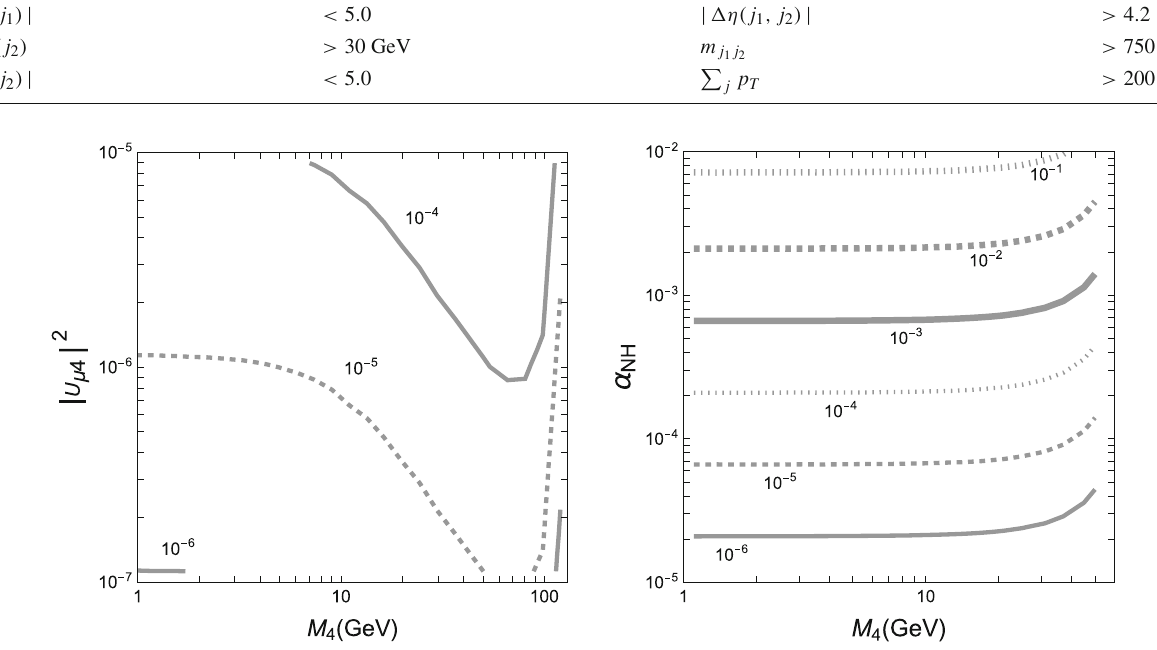
Fig. 2 Contours for heavy neutrino production cross section, in pb. The left (right) panel shows single (double) heavy neutrino production, for the minimal (extended)